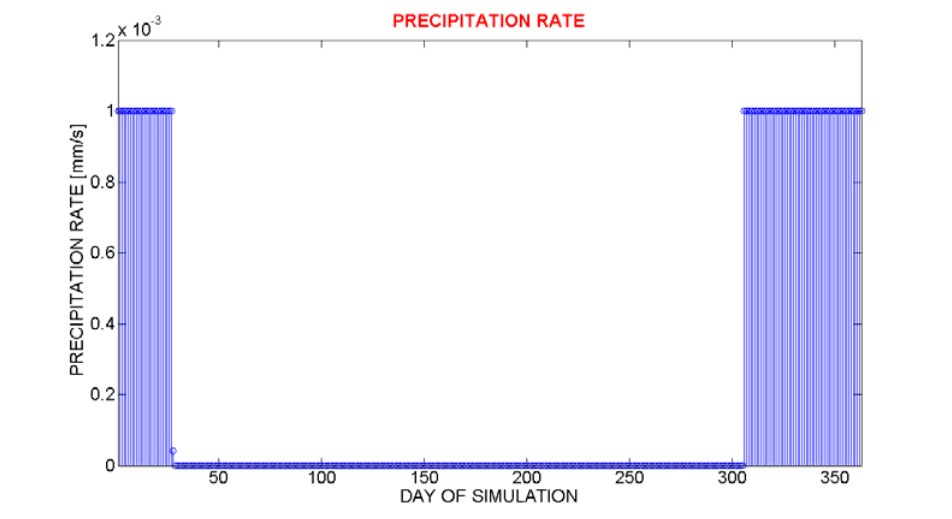
Figure 3. Daily mean precipitations used in the synthetic data.